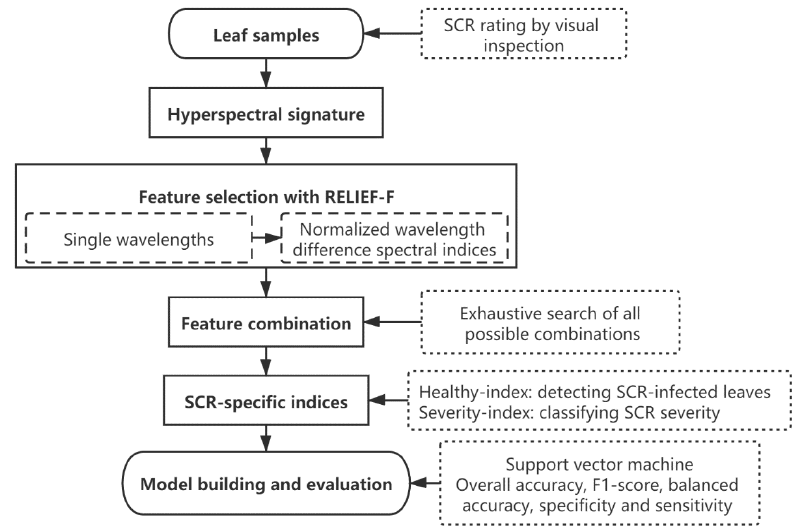
Figure 2. Flowchart of the methodology.